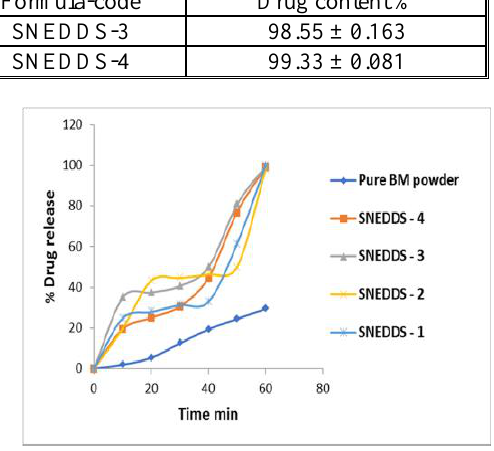
Figure 3. A comparative dissolution profile of BM SNEDDS formulas (F1, F2, F3, F4 ) and pure